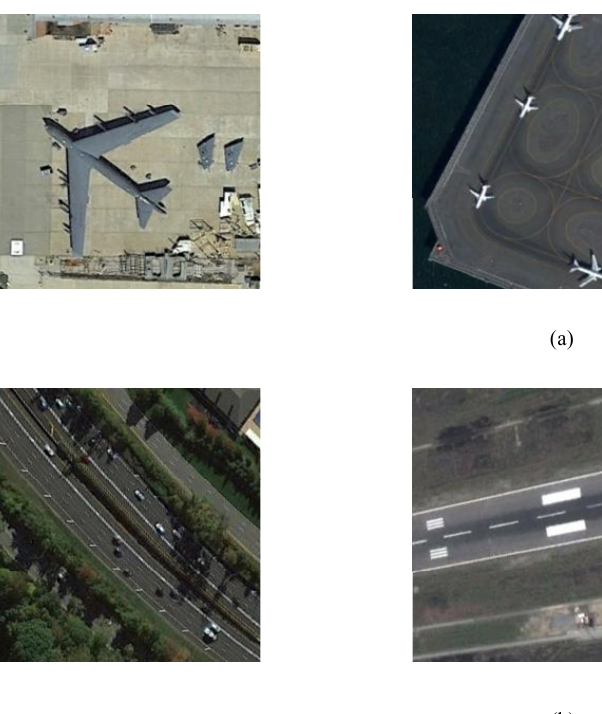
Figure 1. Scene labels (shown in green font) and object labels (shown in red font) for remote-sensing images. ( a ) Scene labels: River. Object labels: Field, Forest, Residential, Pavement. ( b ) Scene labels: Overpass. Object labels: Buildings, Grass, Parking, River.